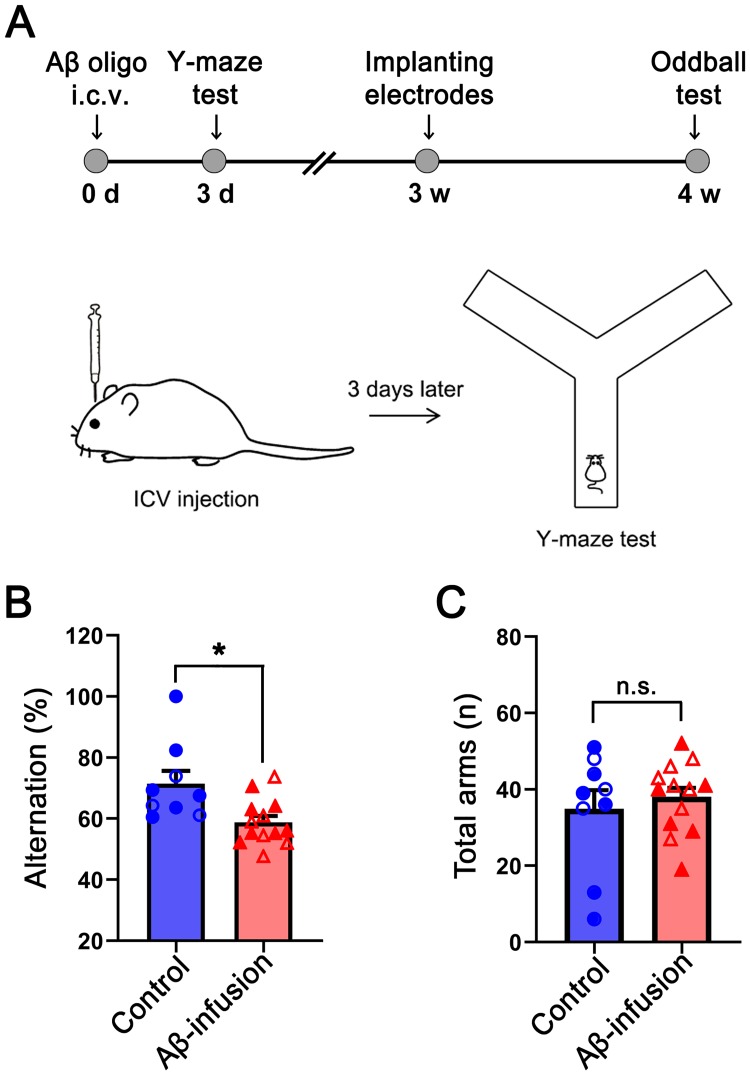
Y-maze behavioral test.(A) The experimental time-line for all experimental procedures for Y-maze spontaneous alteration test and auditory oddball ERP test (up). Detailed study design for assessing working memory ability following intracerebroventricular (ICV) injection of Aβ using Y-maze(bottom). (B) Mean percent alteration of Aβ-infused (red) and control (blue) groups is depicted in the bar graph with error bars representing SEM. The value of each individual is indicated by a dot on the bar graph. Filled dots represent individual mice used both behavioral test and auditory oddball test. (C) The bar graph represents the mean and SEM of total arm entries in the Aβ-infused and control groups (Student’s t-test p < 0.05 as significance level). d: day; w: week.